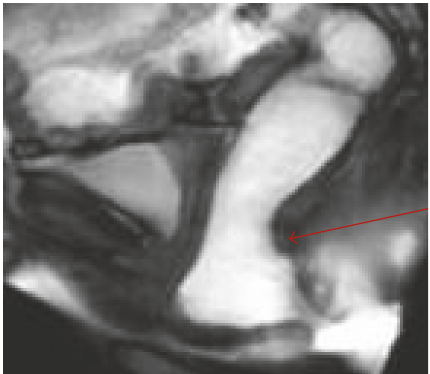
Figure 6: Example of wrong indication to STARR operation: postoperative MR defecography in patient with persistent nonrelaxing puborectalis muscle (arrow), responsible of recurrent rectocele and